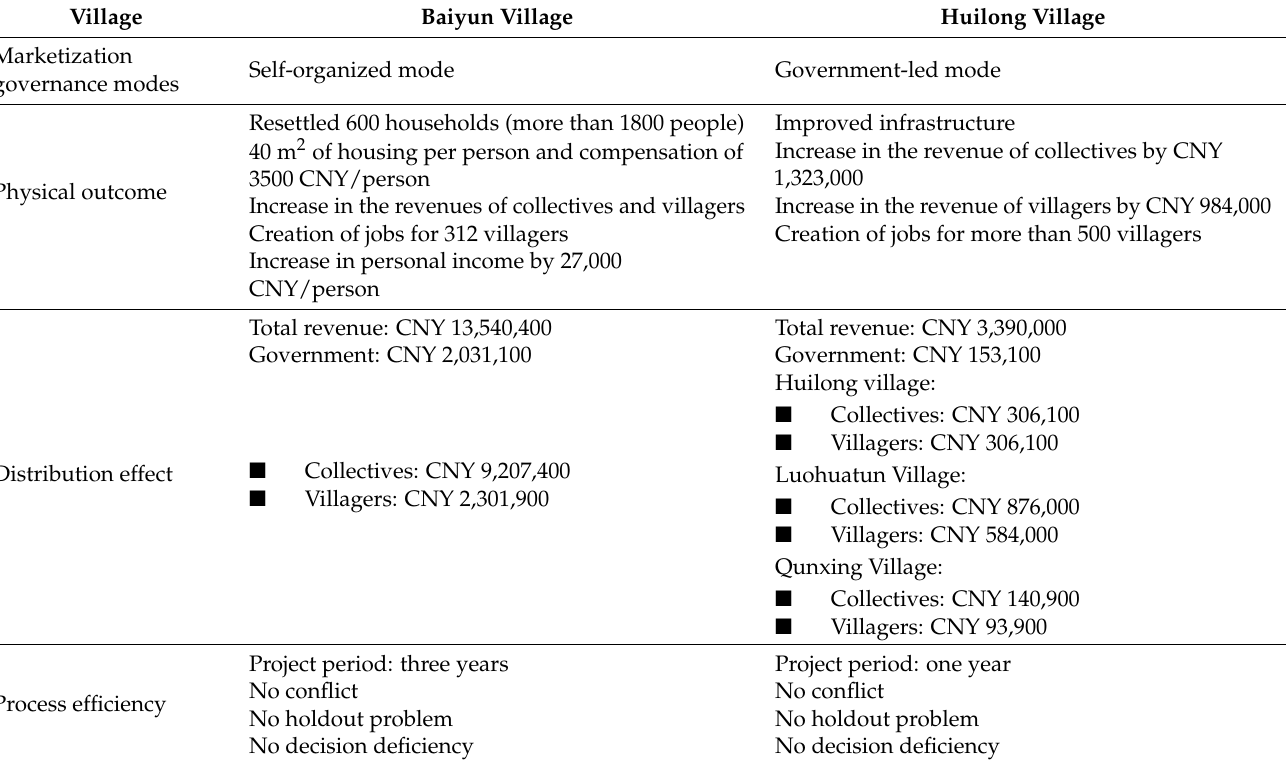
Table 6. Comparison of the CCCL projects between Baiyun Village and Huilong Village in terms of the performance differences.